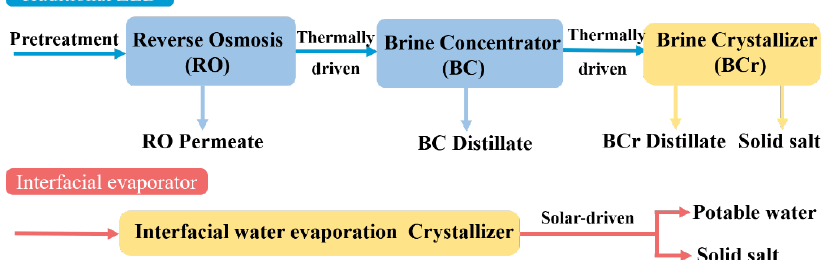
Figure 1. A schematic diagram of traditional ZLD and interfacial evaporator. (Reprinted with permission from Ref. [12]. 2022, with permission from Elsevier).